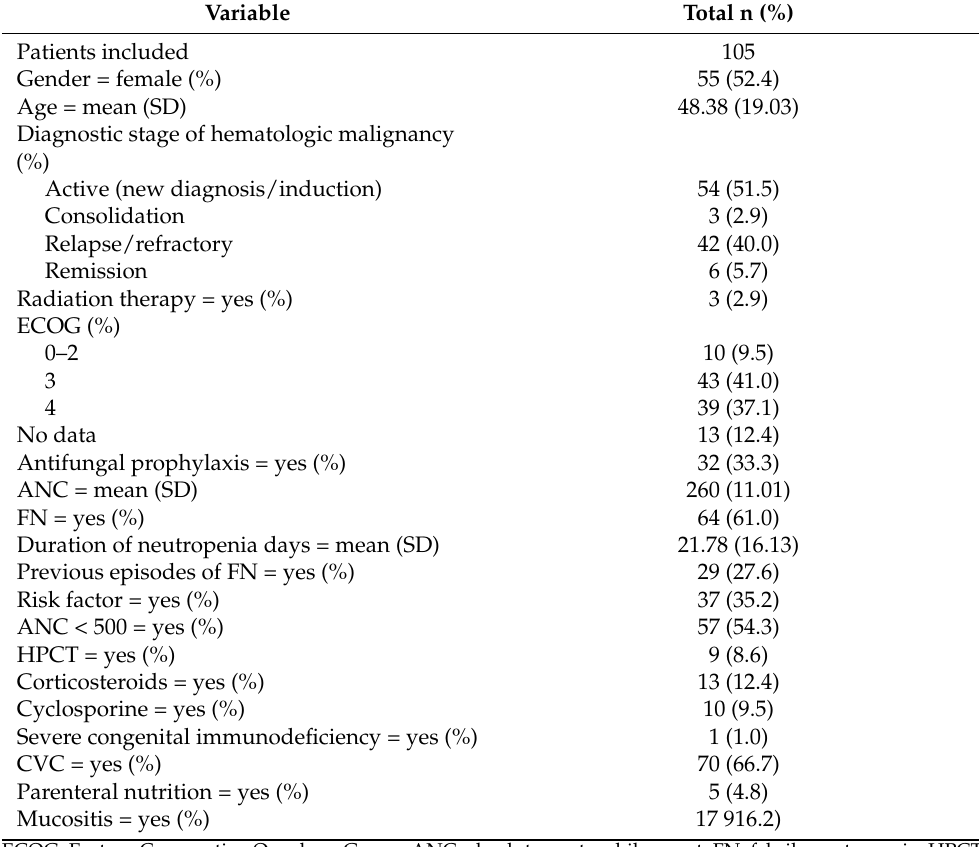
Table 1. Clinical characteristics and risk